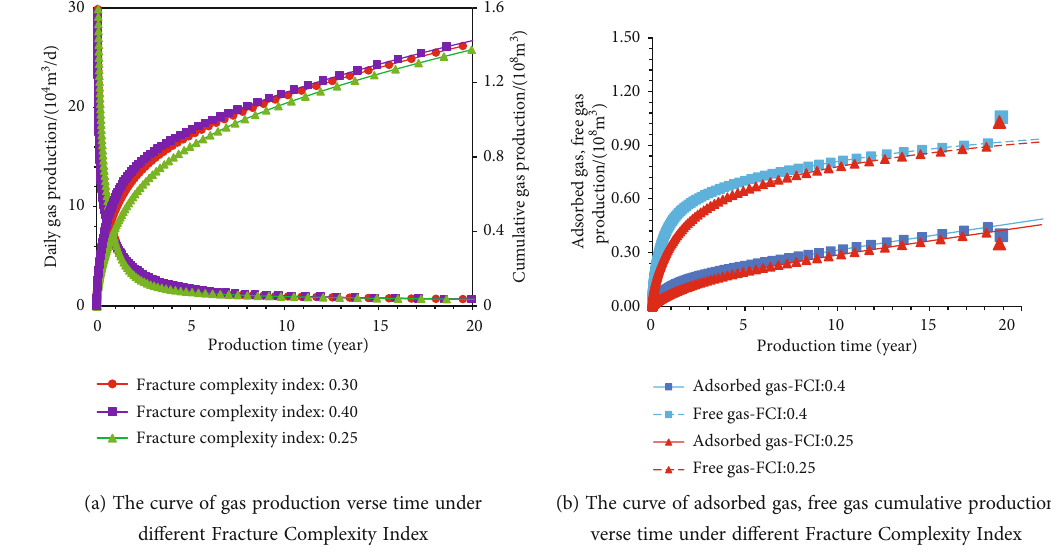
Figure 9: E ff ect of di ff erent FCI value on shale gas production.